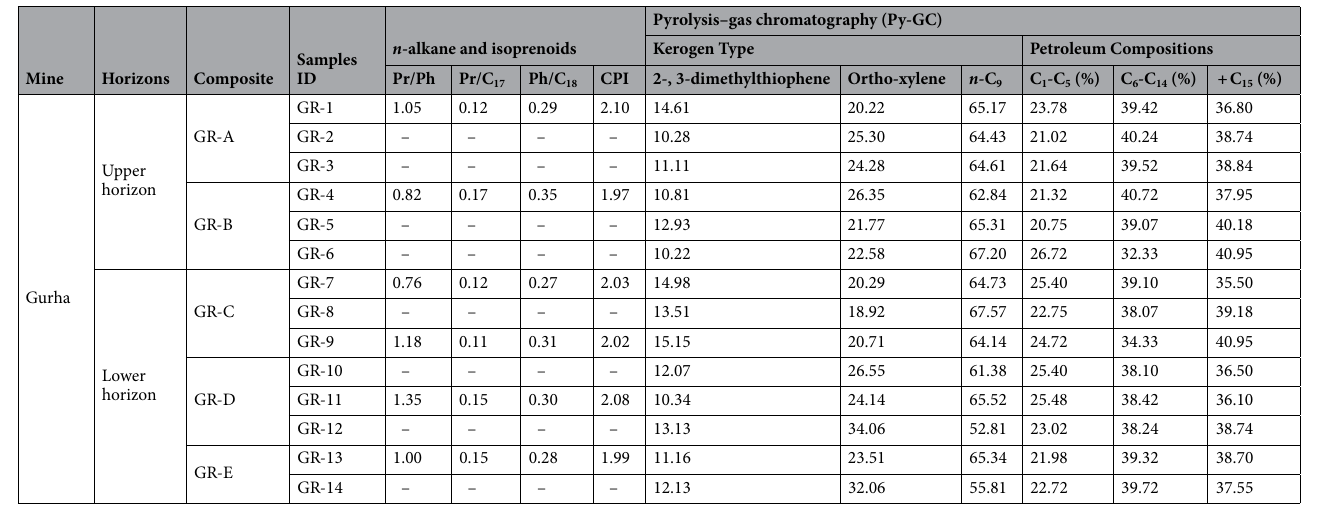
Table 2. Quantitative chemical results of extracted shale samples in the Gurha mines at Bikaner, Rajasthan, including some compounds calculated from Py–GC pyrograms and mass fragmentogram of m/z 85 ion in GC–MS of the saturated hydrocarbon. Pr, Pristane; Ph, Phytane; CPI, Carbon preference index (1):